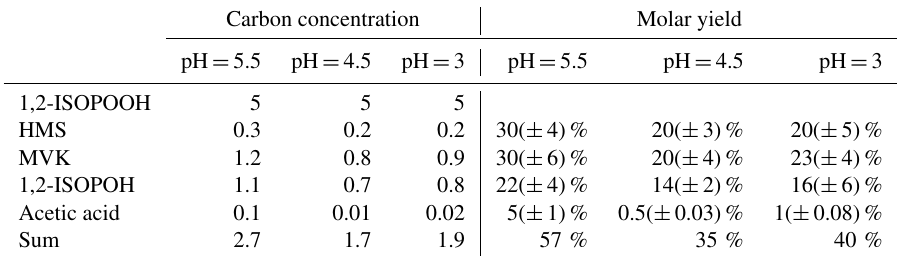
Table 2. Carbon budget of the 1,2-ISOPOOH + SO 2 , aq reaction and molar yields. Carbon concentrations are in mM. Hydrated formaldehyde could not be quantified as it is under the large D 2 O signal. At lower pH, acetic acid may be lost to the gas phase. Carbon concentration Molar yield pH = 5.5 pH =